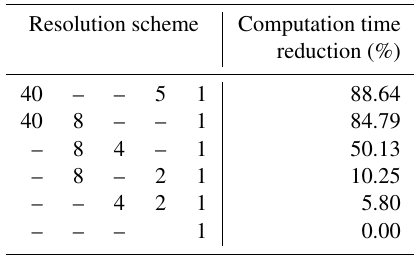
Table 3. Total computation time relative to the 1km benchmark ex- periment for several resolution schemes, sorted